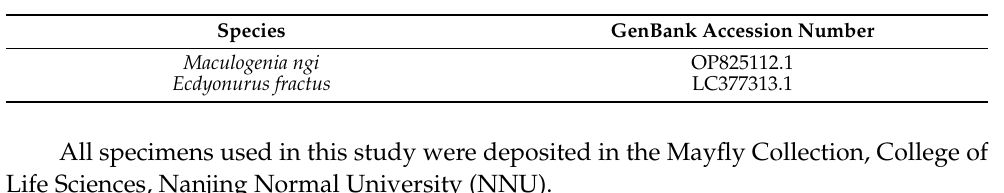
Table 1. GenBank Accession Numbers of the COI sequences used in this research.